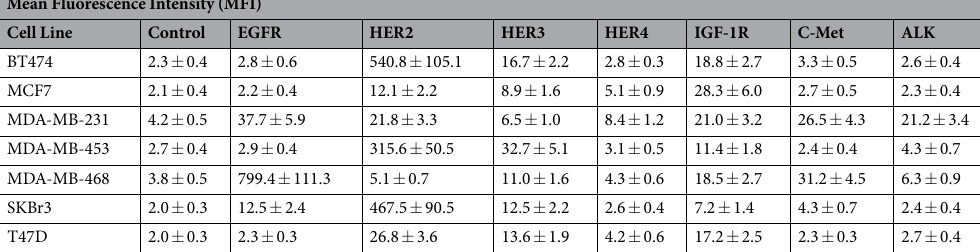
Table 1. Expression of RTKs in breast cancer cell lines assessed by Flow Cytometry. The data is presented as the mean fluorescence intensity (MFI) ± Standard Deviation (SD) of gated events Irreversible HER-family TKIs are highly effective at inhibiting growth of HER2 overexpressing cell lines SKBr3 and BT474, but not